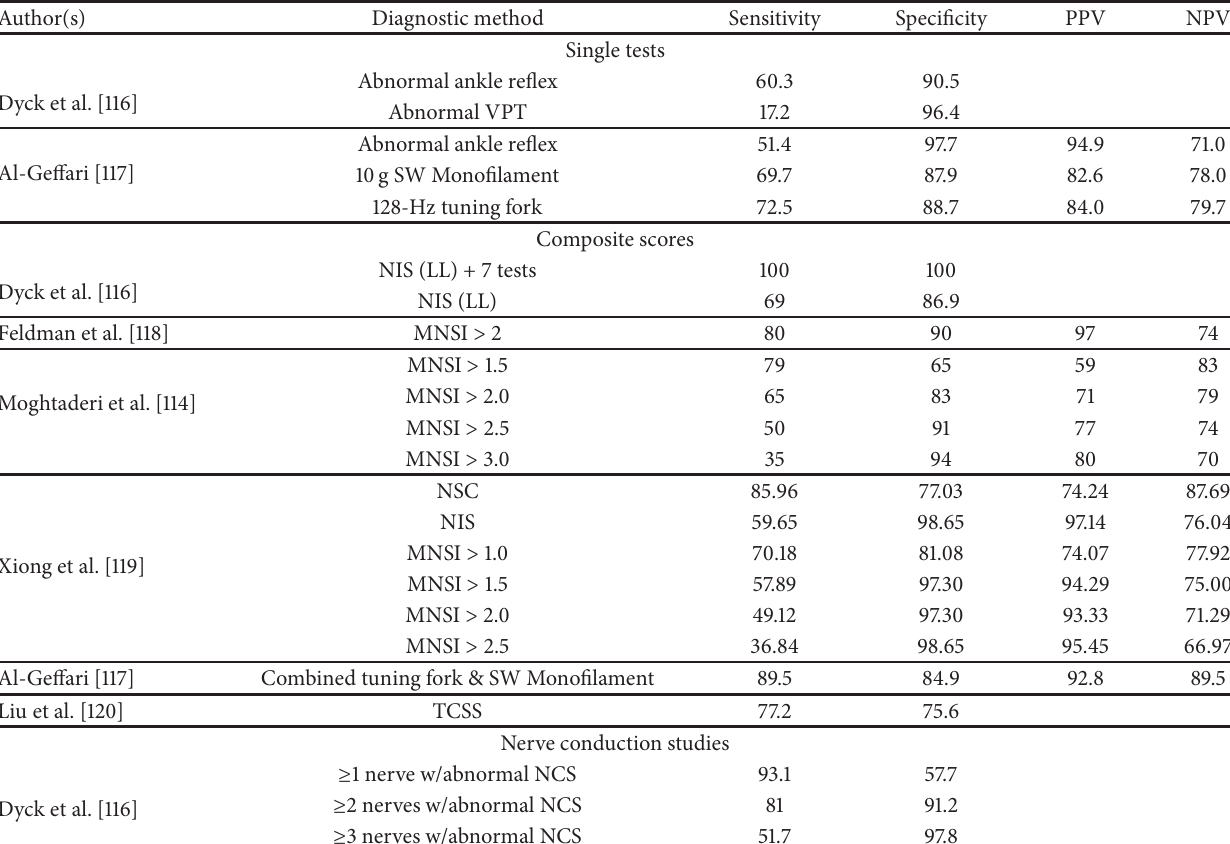
Table 1: Diagnostic methods for